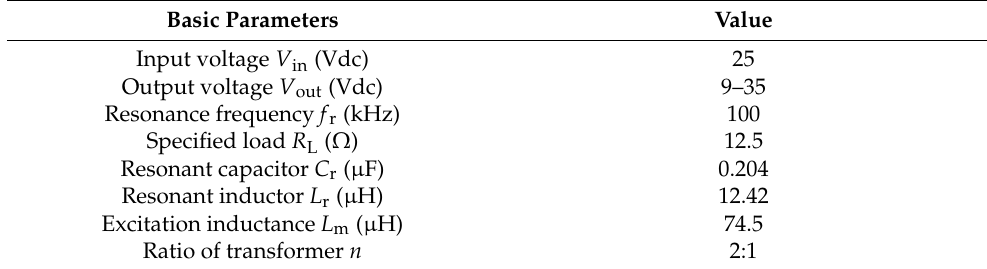
Table 1. Key Parameters of Resonant Converters.